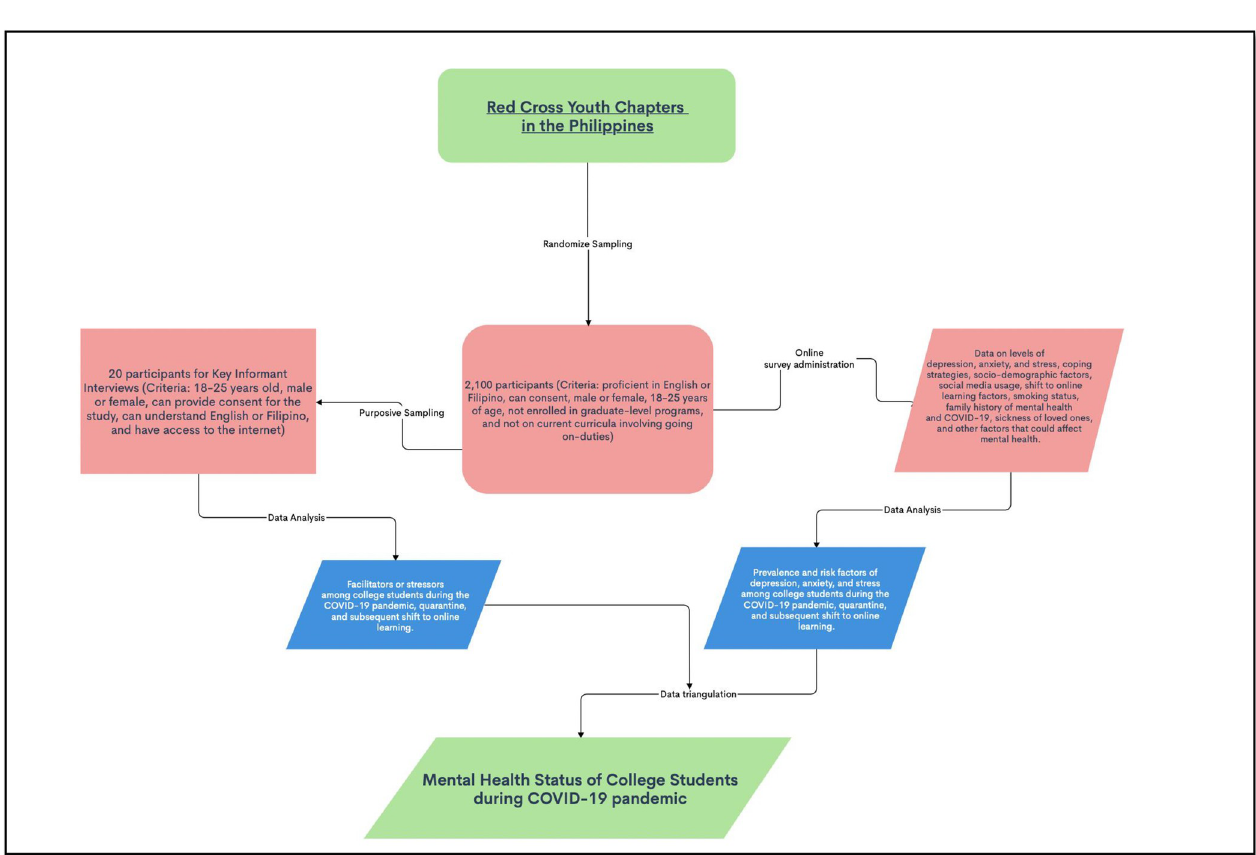
Fig 1. Flow chart of the assessment of mental health status of college students during COVID-19 pandemic.